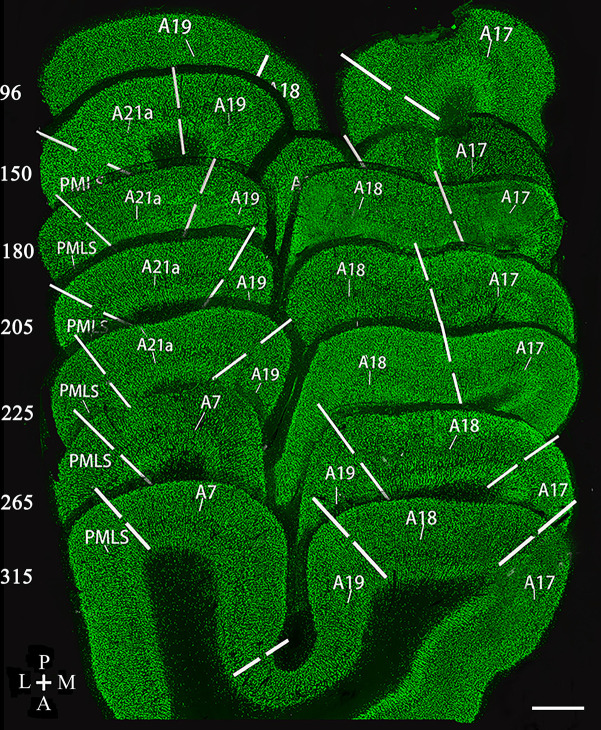
Reconstruction of coronal section samples showing estimates of the border (solid lines) between visual cortical area 17 (A17), 18 (A18), 19 (A19), 21a (A21a), PMLS, and 7 (A7) according to previous studies (Payne, 1993; Dreher et al., 1996b; Rushmore and Payne, 2004; Huang et al., 2006; Connolly et al., 2012; Stolzberg et al., 2017). The number on the left of each section indicates the serial section number counted along with posterior (P)-to-anterior (A) direction, which corresponds approximately to the Horsley–Clarke coordinates at P8, P4, P3, P2, P1, A2, and A4. The section thickness is 40 μm. The scale bar (in the lower right corner) equals to 1,000 μm.